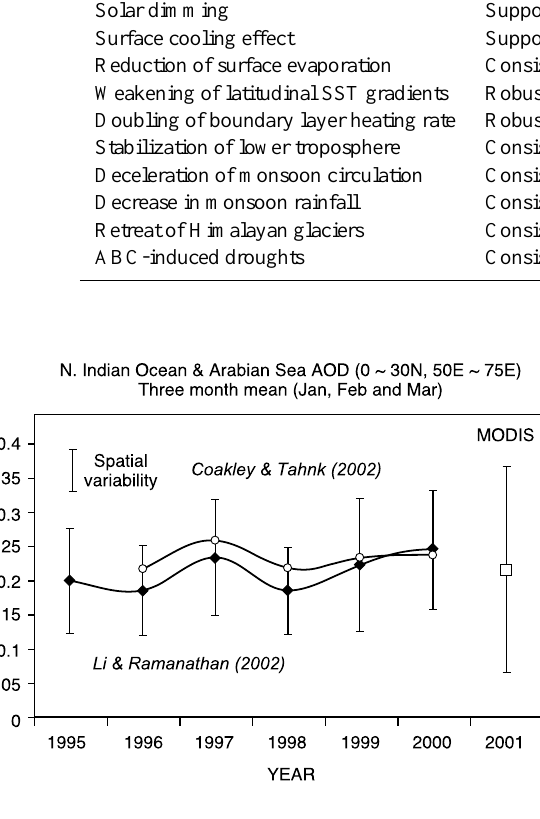
Fig. 35. Interannual variability of the mean satellite-observed aerosol optical depth (AOD) averaged over the northern Indian Ocean and the Arabian Sea; closed symbols are from Li and Ra- manathan (2002), open symbols from Tahnk and Coakley (2002) (from Ramanathan et al., 2002, copyright 2002 by the Indian Academy of Sciences, reproduced with permission).